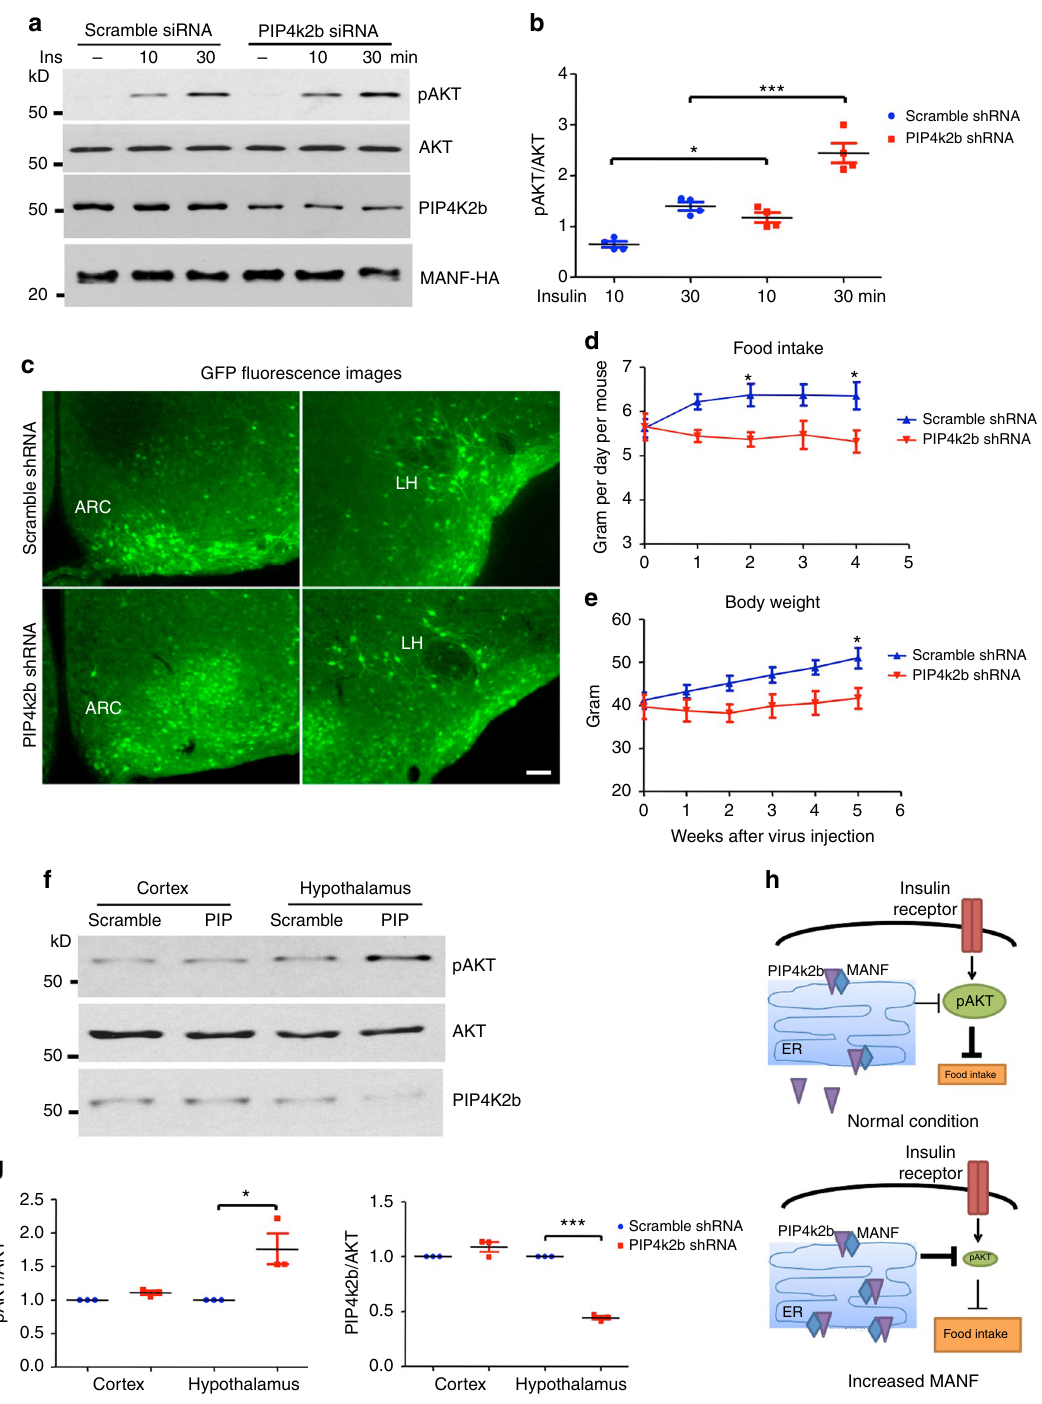
Fig. 8 Reducing PIP4k2b ameliorates MANF mediated insulin resistance. a Representative western blotting images (from three independent experiments) of pAKT levels in PC12 cells treated with insulin (Ins) for different lengths of time: untreated ( − ), 10 min or 30 min. b Quanti fi cation of western blotting results in Fig. 8a (* P < 0.05, *** P < 0.001, n = 4, one-way ANOVA with Tukey post-tests, F = 39.17, P < 0.0001). c GFP fl uorescence was used to indicate the areas with shRNA expression in mice injected with either AAV-scramble-shRNA or AAV-PIP4k2b-shRNA ( Scale bar : 100 μ m). d Food intake of MANF TG mice injected with either AAV-scramble-shRNA or AAV-PIP4k2b-shRNA was measured weekly after viral injection (* P < 0.05, n = 6, two-way ANOVA with Bonferroni post-tests, F = 23.17, P < 0.0001). e Body weights of MANF TG mice injected with either AAV-scramble-shRNA or AAV-PIP4k2b-shRNA were measured weekly after viral injection (* P < 0.05, n = 6, two-way ANOVA with Bonferroni post-tests, F = 23.63, P < 0.0001). f Representative western blotting images (from three independent experiments) of pAKT levels in MANF TG mice injected with either AAV-scramble-shRNA (Scramble) or AAV- PIP4k2b-shRNA (PIP) in the hypothalamus, and then treated with insulin. g Quanti fi cation of western blotting results in Fig. 8f (* P < 0.05, *** P < 0.001, n = 3; 2-tailed student t test, pAKT, t = 3.323, P = 0.0399; PIP4k2b, t = 33.09, P = 0.0009). Data are represented as mean ± SEM. h